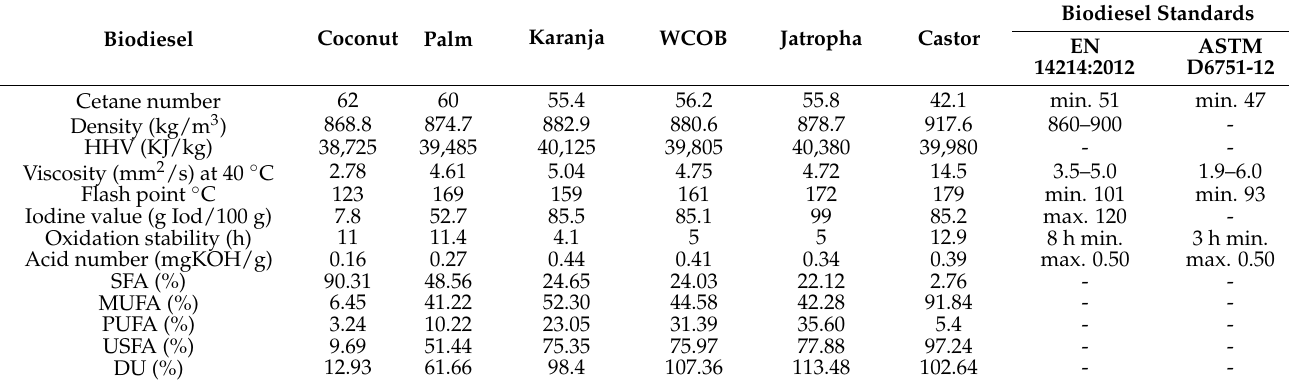
Table 4. Fuel properties of various biodiesels.